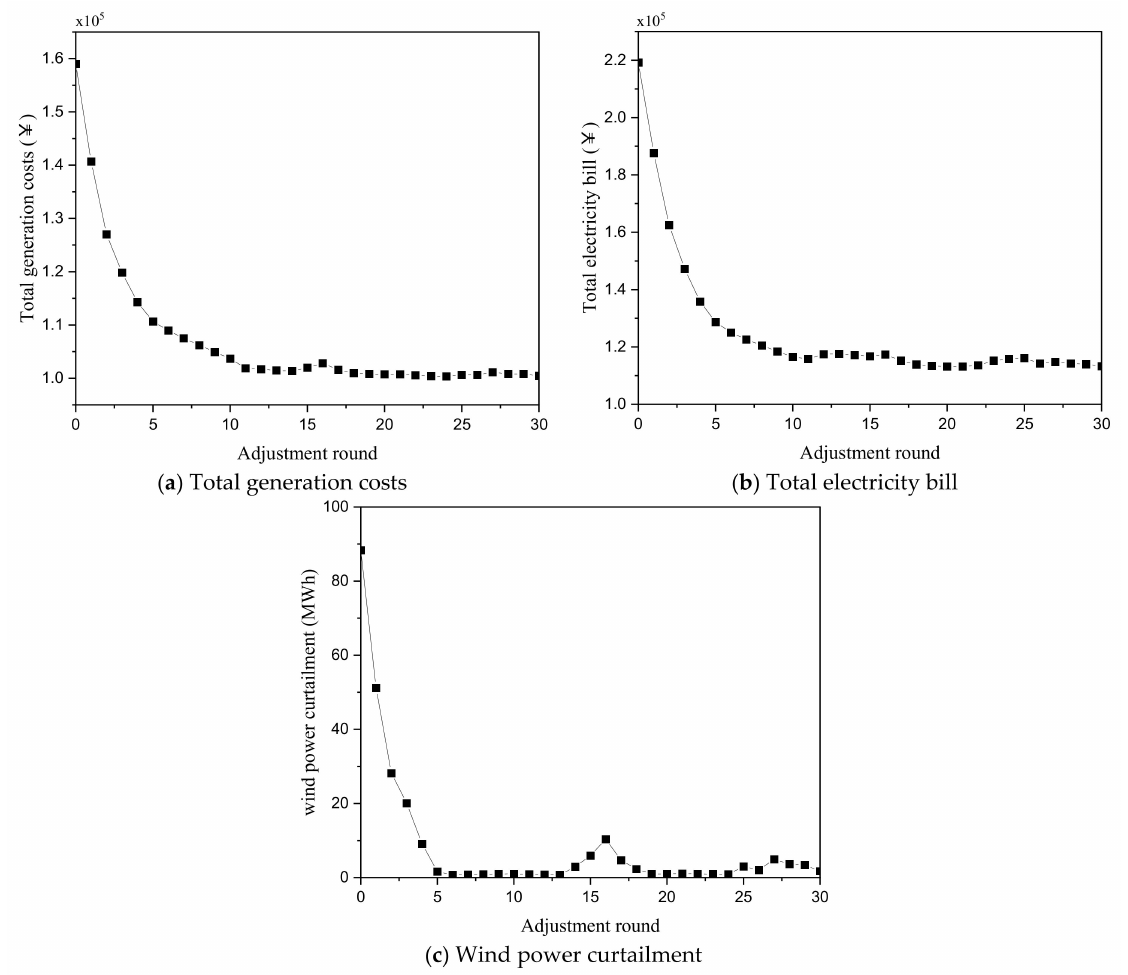
Figure 9. Changes of Evaluation Indexes with the Adjustment